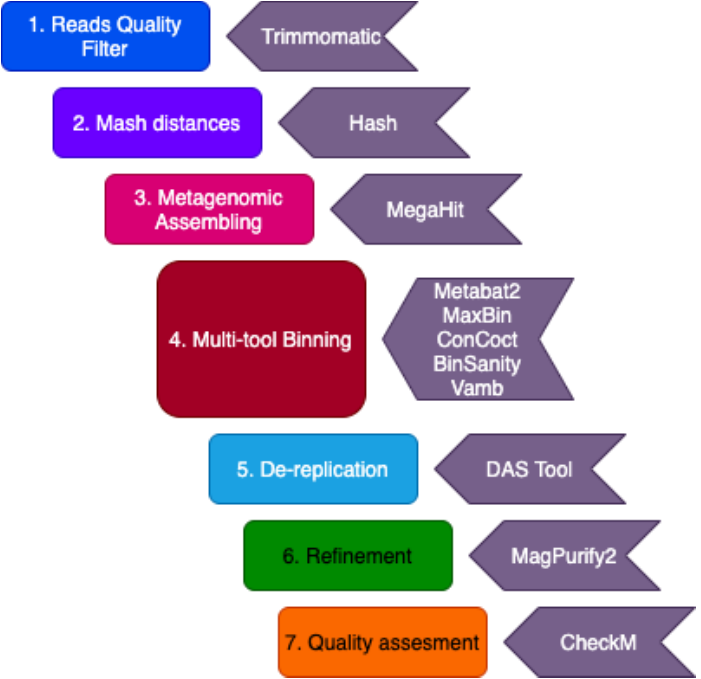
Figure 2. Computational pipeline for obtaining MAGs.